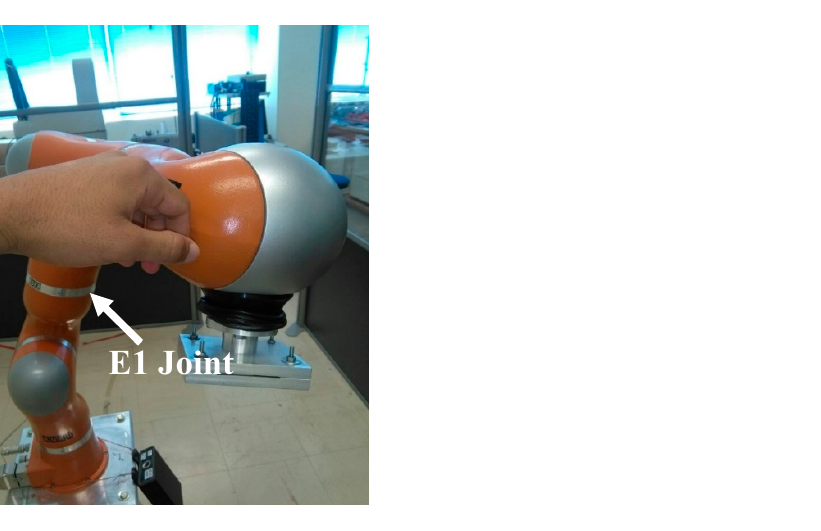
Figure 3. The setup for experiments with the KUKA LWR IV robot. This figure is taken from our previous work presented in [19,20].